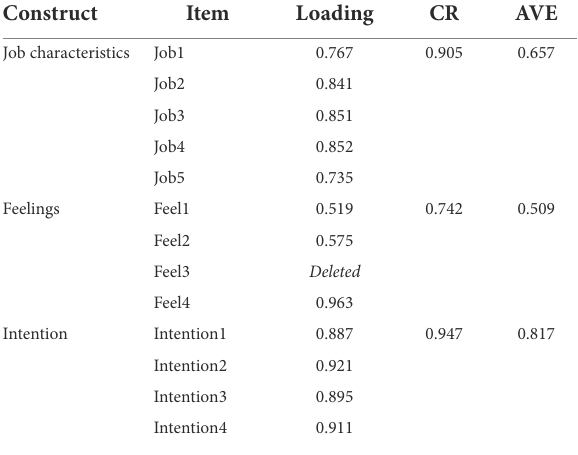
TABLE 2 Assessment of internal consistency and convergent validity. TABLE 3 Heterotrait monotrait (HTMT) criterion for discriminant